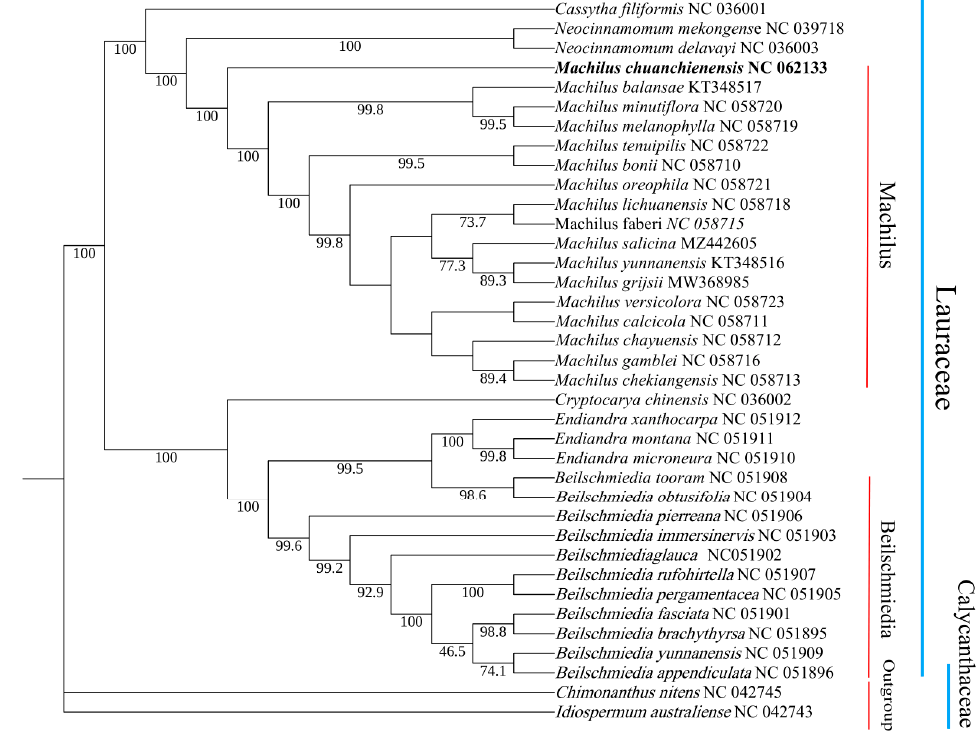
Figure 7. Maximum-likelihood phylogenetic tree of M. chuanchienensis based on the whole chloro- plast genomes of 36 previously reported species (Numbers on the nodes are bootstrap values from 1000 replicates).